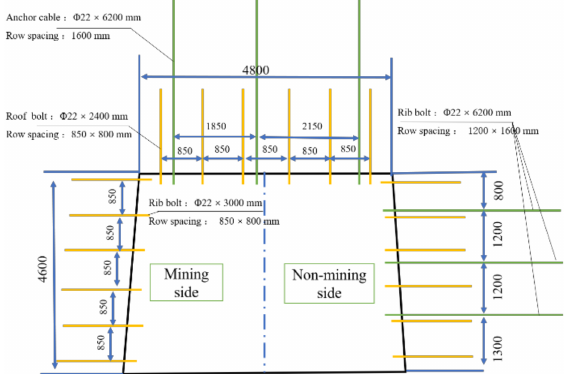
Figure 12. Support scheme of the working face 7302.